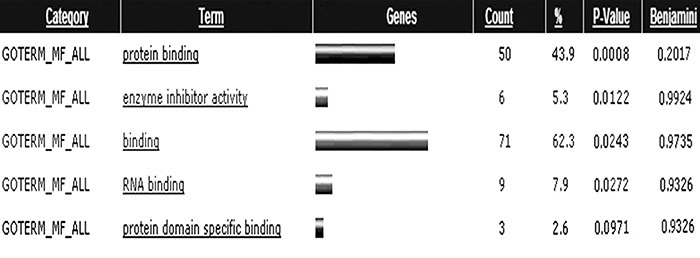
Molecular function categories of genes regulated by ropinirole (ROP).
GOTERM_Molecular Function_ALL revealed that most of these genes functioned in
protein and RNA binding, and in enzyme inhibitor activity.